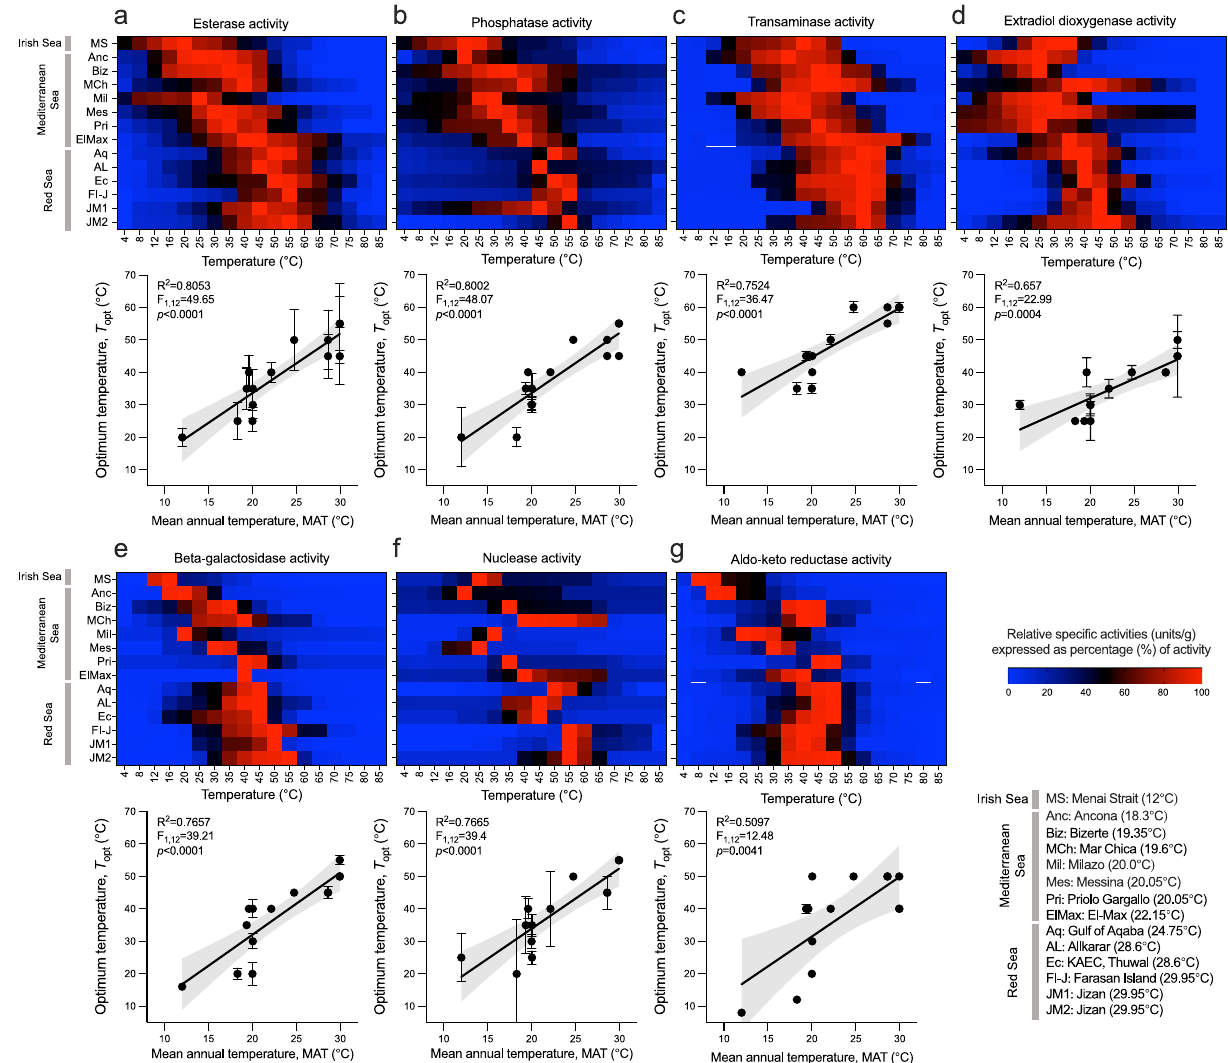
Fig. 1 | Thermal adaptation of microbial community isozymes from sea sedi- ments. a – g Thermal pro fi les for a esterase, b phosphatase, c transaminase, d extradiol dioxygenase, e beta-galactosidase, f nuclease, and g aldo-keto reduc- tase activities of total microbial proteins, in their active form, extracted from microbial communities inhabiting marine sediments from different locations encompassing the Irish Sea, Mediterranean Sea and Red Sea (Supplementary Table S1). Heatmaps represent the relative percentages (%) of speci fi c activity at each temperature calculated from the initial enzymatic rate (units/mg; raw data in